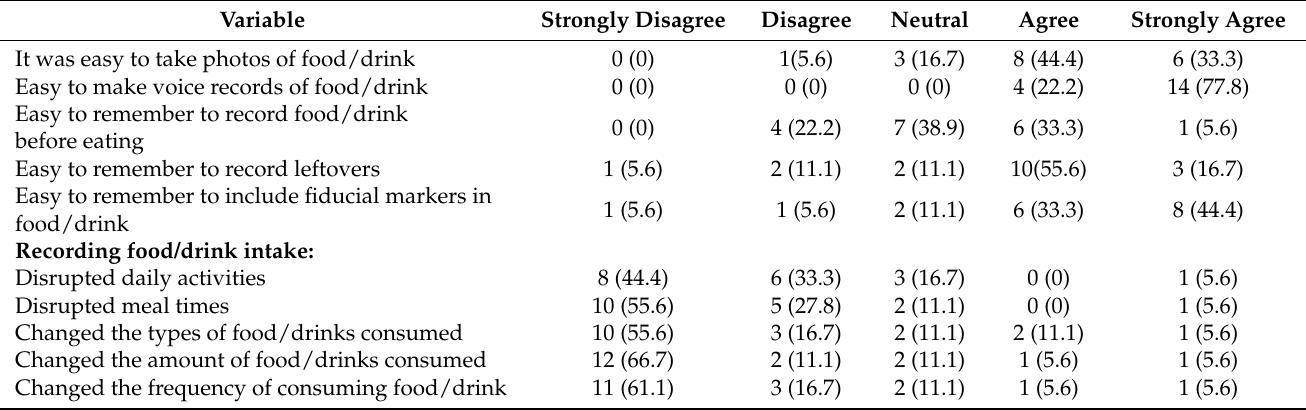
Table 3. Perceptions of the participants on the usability and acceptability of the VISIDA